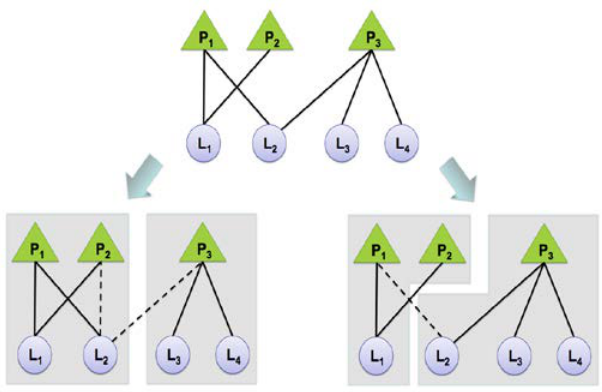
Figure 1: Bi-partite graph representation of GWAS data. Vertices P1, P2, P3 represent “phenotypes” and L1, L2, L3, L4 represent “SNP loci”. Our bi-cluster editing algorithm converts the intransitive GWAS data graph into disjoint bi-cliques. Two putative solutions are presented at the bottom: the addition of edge P2-L2 and the deletion of edge P3-L2 (left) as well as the deletion of edge P1-L2 (right). In the unweighted bi-cluster editing problem we would prefer the right solution since we only need to modify one edge. However, in the more